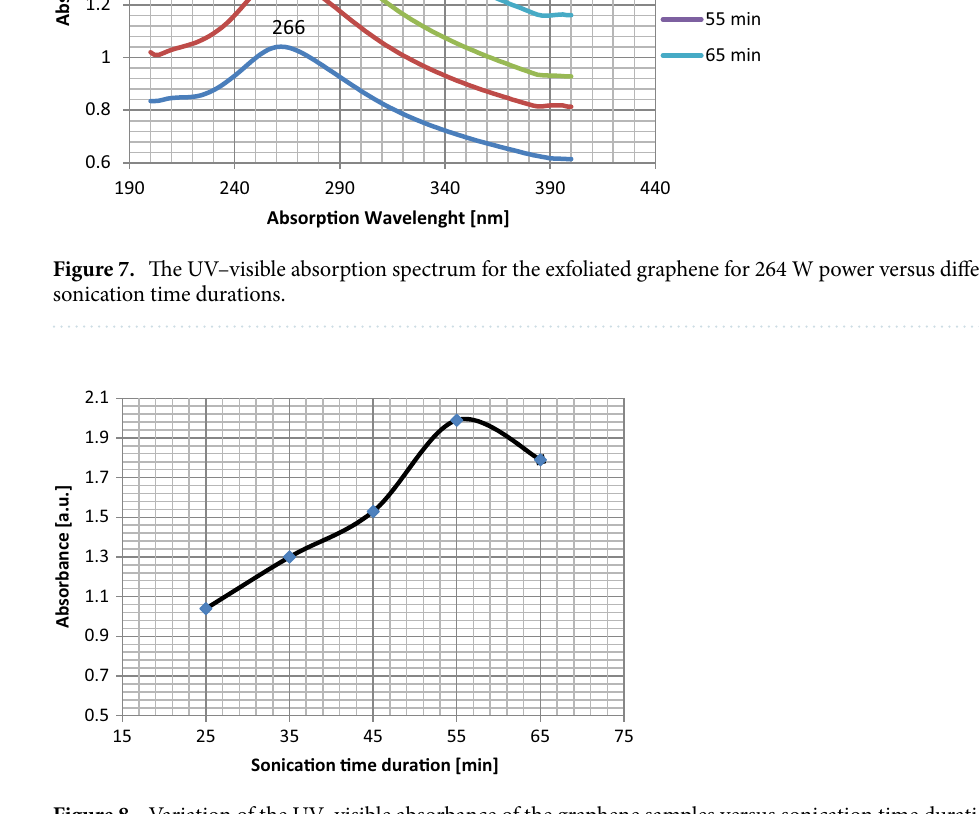
Figure 8. Variation of the UV–visible absorbance of the graphene samples versus sonication time